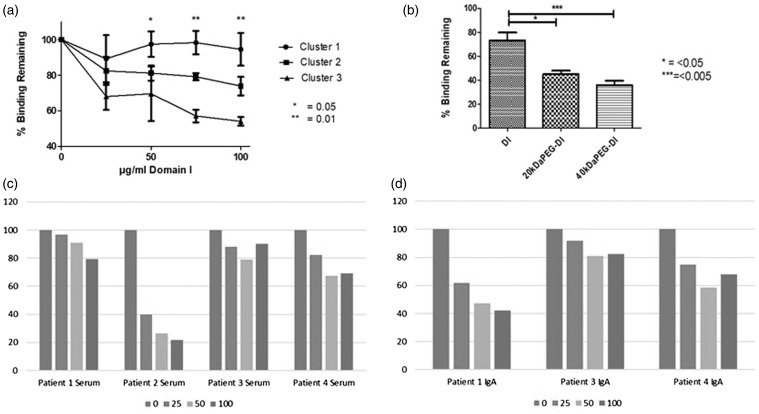
Results of assays to measure inhibition of IgA binding to β2GPI.(a) The inhibition of IgA aβ2GPI in serum from 13 patients separated into three clusters. Cluster 1 had no inhibition, cluster 2 had moderate inhibition and cluster 3 had the highest inhibition. Significant differences are seen between clusters 1 and 3 at concentrations ≥50 µg/ml DI and between clusters 1 and 2 at ≥75 µg/ml DI. (b) Inhibition by DI and PEG-DI in 10 of these patients tested with 20 kDa PEG-DI and 40 kDa PEG-DI. Both PEGylated variants show significantly enhanced inhibition. (c) Inhibition by non-PEGylated DI in IgG depleted serum for all four patients from cluster 3. Inhibition can be seen in all four patients and is dose-dependent in three cases. (d) Inhibition of purified IgA from three of the patients from cluster 4 (it was not possible to purify sufficient IgA from serum of patient 2). Inhibition can be seen in all three patients.aβ2GPI: anti-beta-2-glycoprotein I; DI: Domain I; PEG: poly(ethylene glycol)